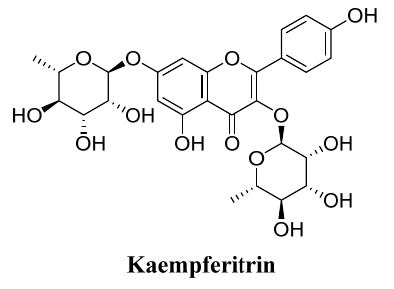
Figure 20. Kaempferitrin. Figure 20.